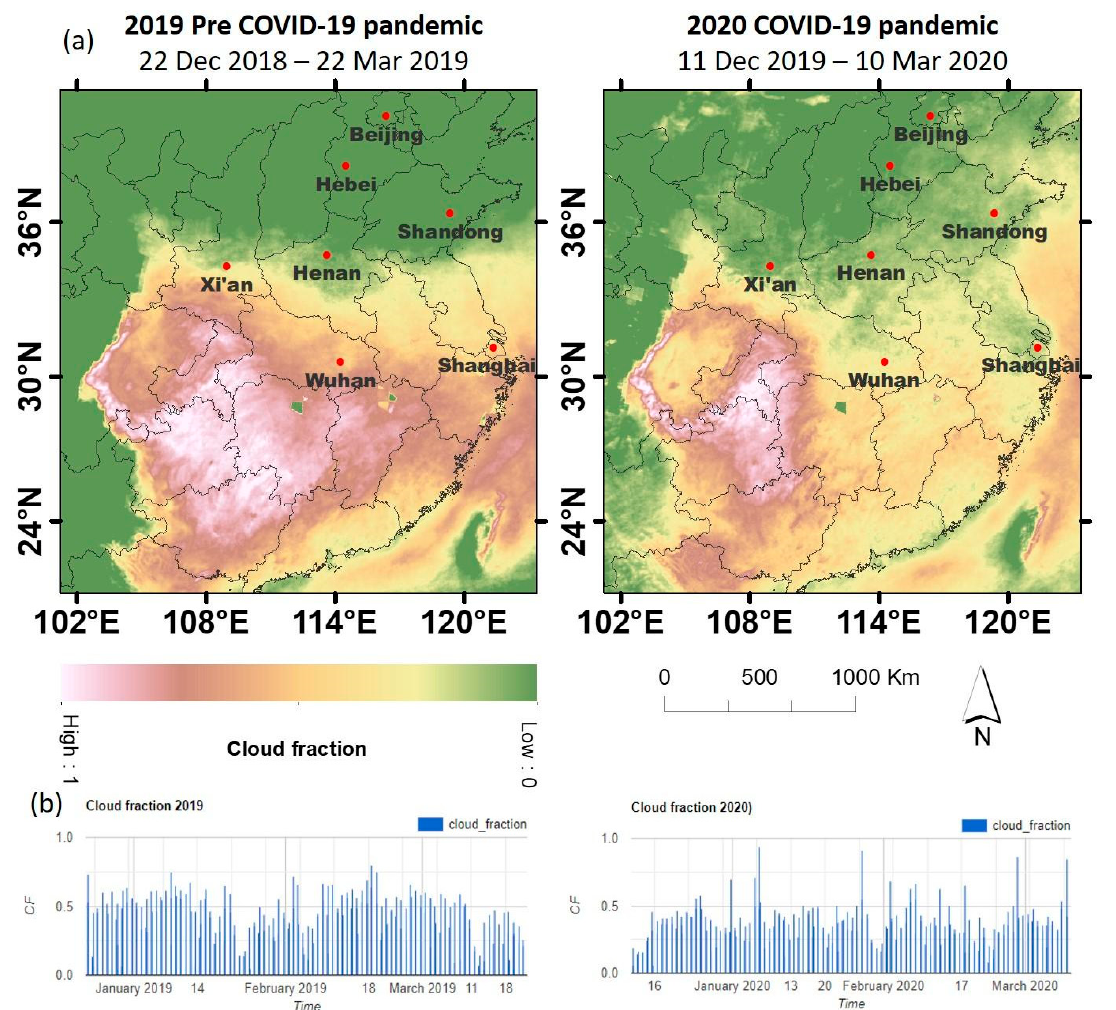
Figure A1. The differences in cloud cover between 2019 and 2020. ( a ) The mean cloud fraction for each period. ( b ) Daily cloud fraction variation.